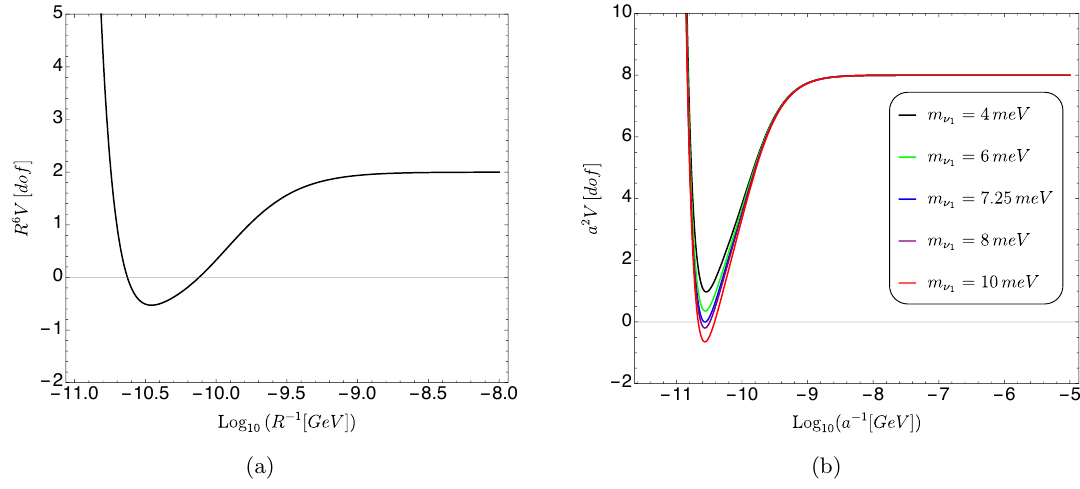
Figure 1 . (a) Radion e(cid:11)ective potential for Majorana neutrinos. The lightest neutrino is considered massless and a minimum develops. For higher energies, the neutrinos behave as massless particles. We have 4 bosonic and 6 fermionic degrees of freedom so, in the massless limit, R 6 V (in units of degrees of freedom) tends to 2. (b) Radion e(cid:11)ective potential for Dirac neutrinos. The di(cid:11)erent lines correspond to several values for the lightest neutrino mass m (cid:23) . We have 4 bosonic and 12 1 fermionic degrees of freedom so, in the massless limit, R 6 V tends to 8. It is important to remember that positive valued minima in this plot do not necessarily correspond to dS minima of V . However, negative minima do correspond to AdS minima of V